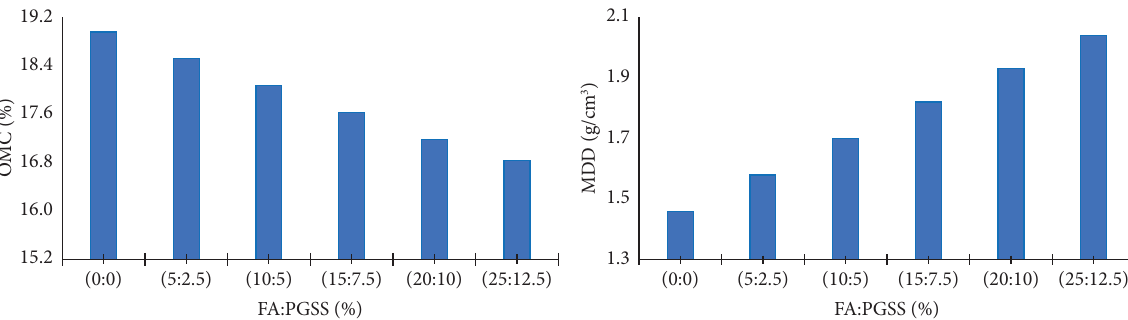
Figure 4: Compaction efect of FA and PGSS addition to expansive soil.